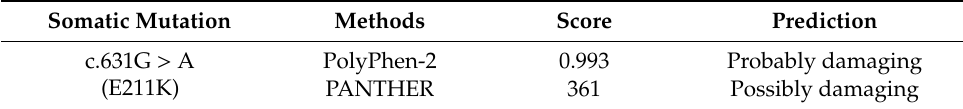
Table 4. In silico evaluation of the impact of K211 somatic mutation on the bovine prion